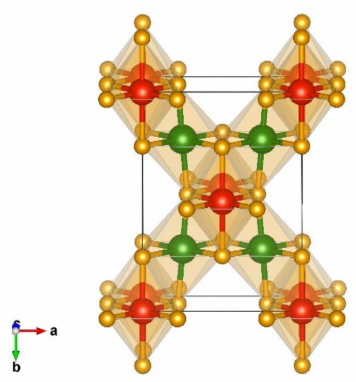
Figure 9. Visualization of non-favorable Cr 2 SiN 4 modification obtained from data-mining referred to as Mn 2 SnS 4 -type in space group Cmmm (no